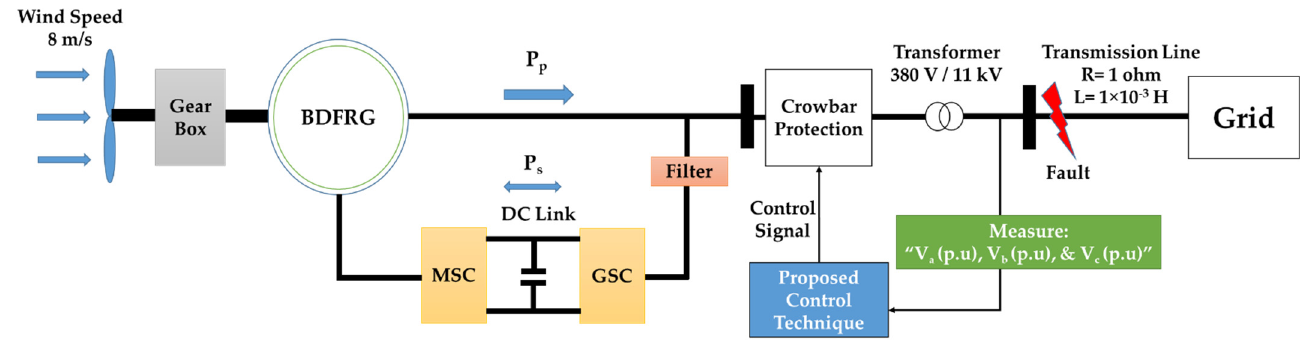
Figure 4. Studied